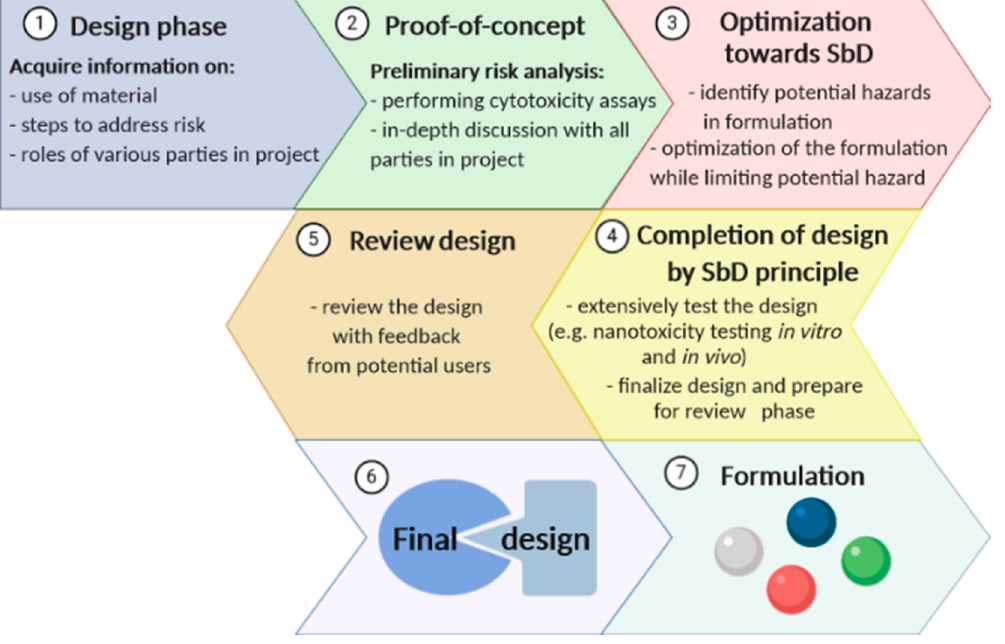
Figure 4. Schematic of the Safety-by-Design principle .